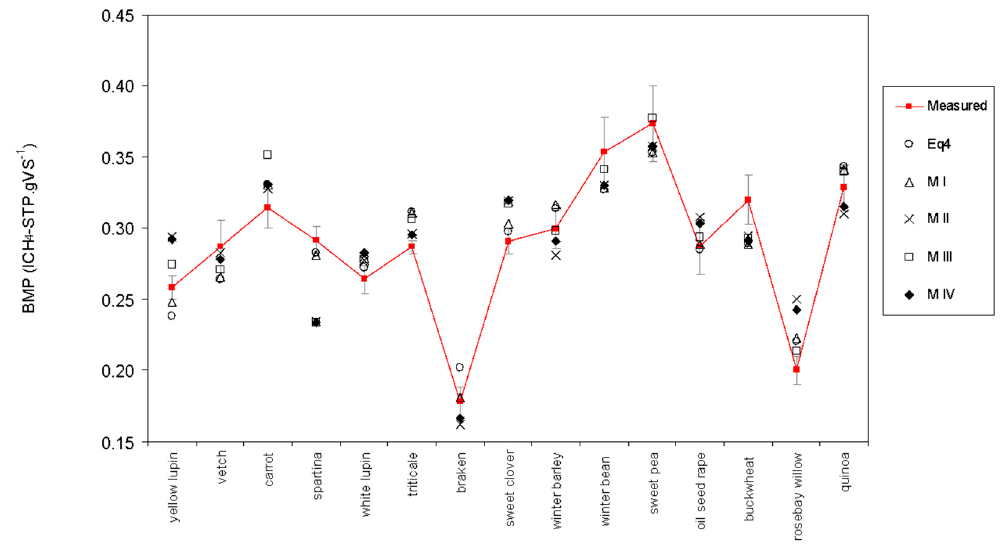
Figure 4. BMP estimation, using different model equations. * Equations are described in Table 4.